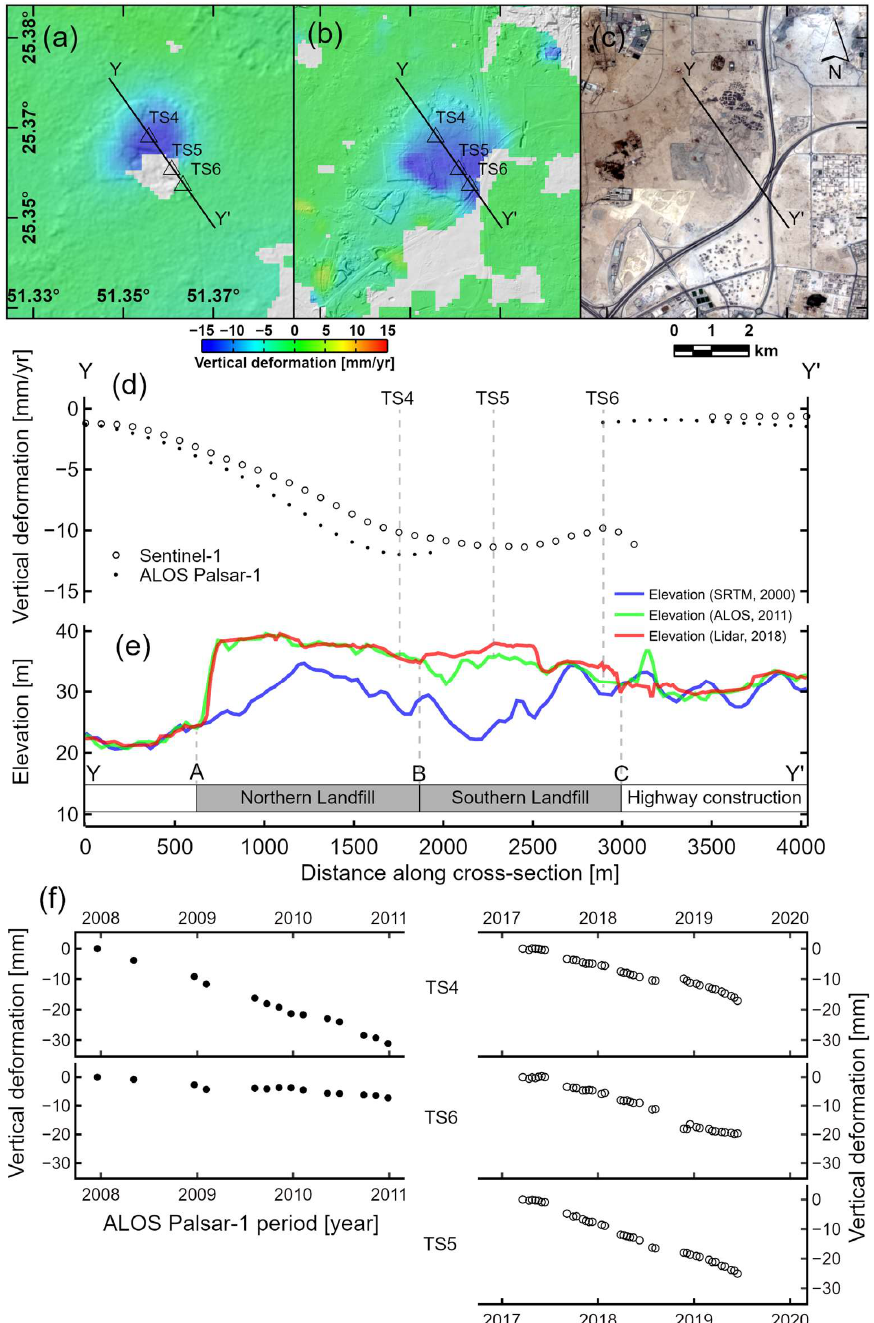
Figure 6. Evolution of the Umm Al-Afai landfill revealed from vertical deformation rates (ALOS Palsar-1 and Sentinel-1) and temporal elevation data. ( a ) Vertical deformation rate extracted from ALOS Palsar-1 dataset. ( b ) Vertical deformation rate extracted from Sentinel-1 dataset. ( c ) Sentinel-2 true color composite (R:B4, G:B3, B: B2) over the area covered by Figure 6a− b . Likewise shown in Figure 6 a − c the locations of profile Y-Y’ and selected points (TS4, TS5, and TS6) along the profile displayed in Figures 6 d − f . ( d ) Deformation rates along profile (YY') derived from ALOS Palsar-1 (black dots) and Sentinel-1 (black circles) datasets and locations of time series points along the transect. ( e ) Elevation profiles extracted from three different DEM sources: SRTM (2000, blue line), ALOS (2011, green line), and lidar (2018, red line). ( f ) ALOS Palsar-1 (black dots) and Sentinel-1 (black circles) time series showing cumulative vertical deformation over TS4, TS5, and TS6.